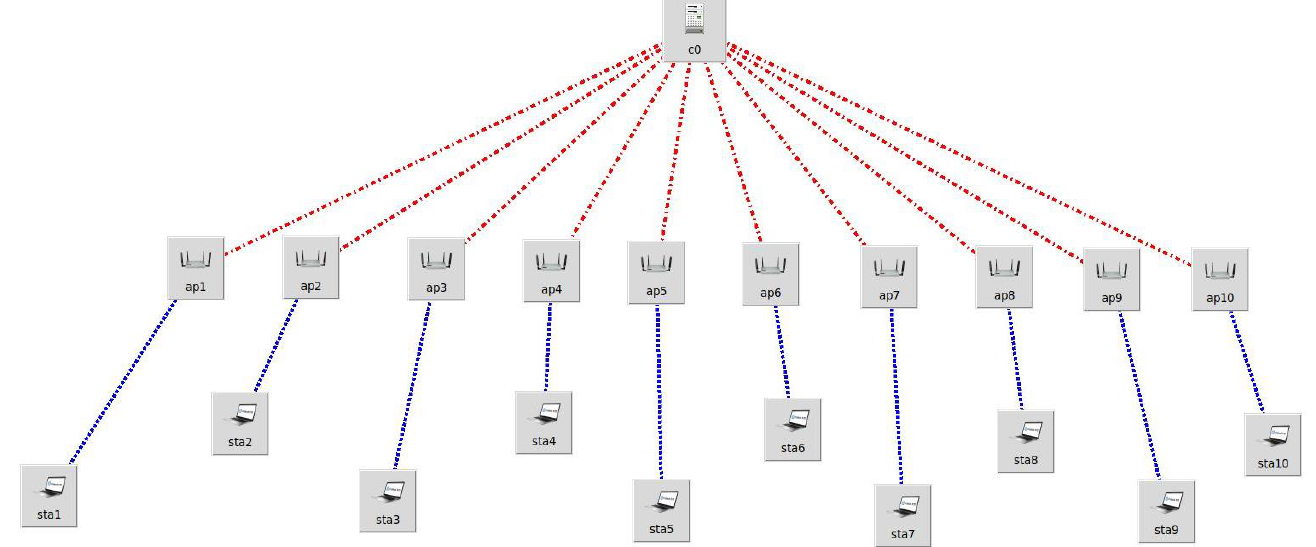
Figure 4. Mininet-Wi-Fi-created linear topology.